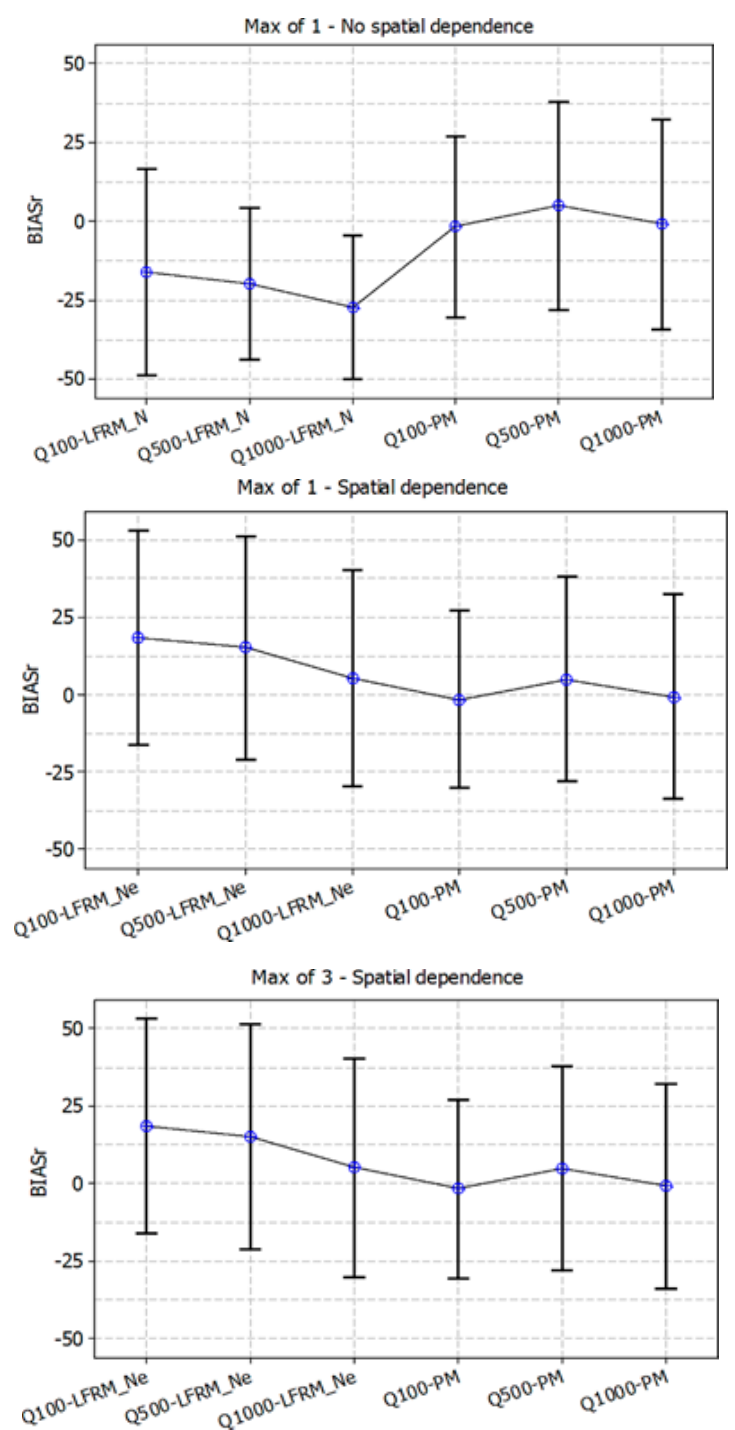
Figure 8. Error bar plot of BIAS r values with the LFRM_N e and PM (world) models for the 28 test catchments. (Top panel) Maxima 1—no spatial dependence; (middle panel) Maxima 1—spatial dependence accounted; (bottom panel) Maxima 3—spatial dependence accounted